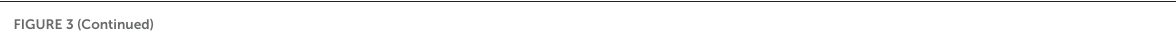
FIGURE3(Continued) (C) Evolution of rats colon permeability and Mucin 2 mRNA levels (AU). Values are means ± SEM different letters indicate significant differences between groups ( P < 0.05) and were obtained by one way Anova or Wilkoxon rank sum test. Number of samples are 16, 16 16 in PF, DSS and PB1 groups for (A) , 14, 14, 13 in PF, DSS and PB1 groups for (B) and (C) . IL10 , Interleukin 10; IL12-a , Interleukin 12A, IFNG , Interferon Gamma; TNFA , Tumor Necrosis Factor Alpha; IL1B , Interleukin 1 Beta; IL6 , Interleukin 6; IL17 , Interleukin 17; IL18 , Interleukin 18; OCLN , Occludin; ZO-1